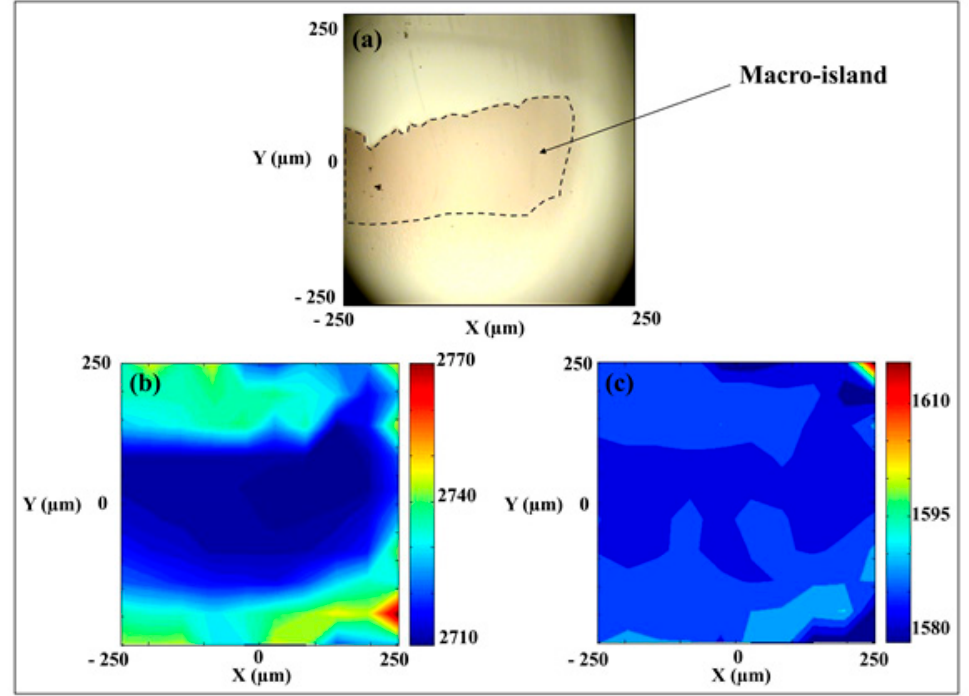
Figure 9. Raman spectroscopy mapping of an epitaxial graphene macro-island, containing four layers: ( a )—The local optical image. Its size is approximately 400 × 200 μ m 2 ; ( b )—the 2D mode position. The 2D shift frequency across the graphene island is substantial ~20–30cm − 1 (to lower energies) and cannot be assigned to substrate effect, nor to the variation in the layer numbers; and ( c )—the G mode Raman shift position. G mode shifts by about 5–7cm − 1 to higher energies. The effect can be explained by mechanical changes (strain) in the layer [107].